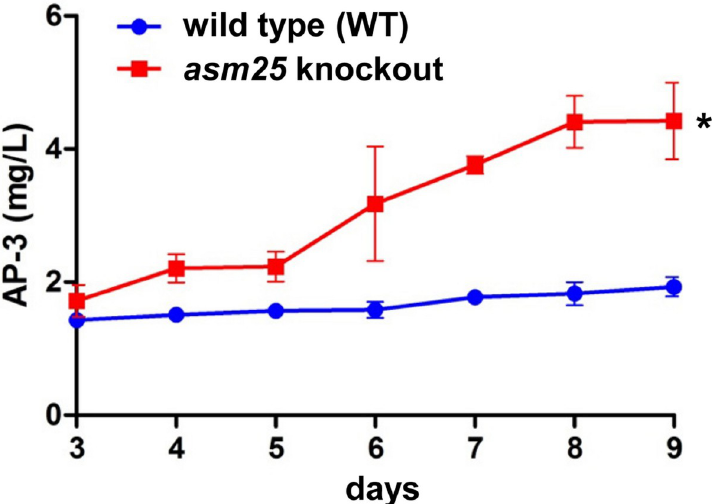
Fig 4. Determination of AP-3 yield in asm25 knockout and WT strains by HPLC. Student’s t test was used for statistical analysis. � : p < 0.05. The mean ± SD from three independent experiments (n = 3) are presented. Blue line: WT strain; Red line: asm25 knockout